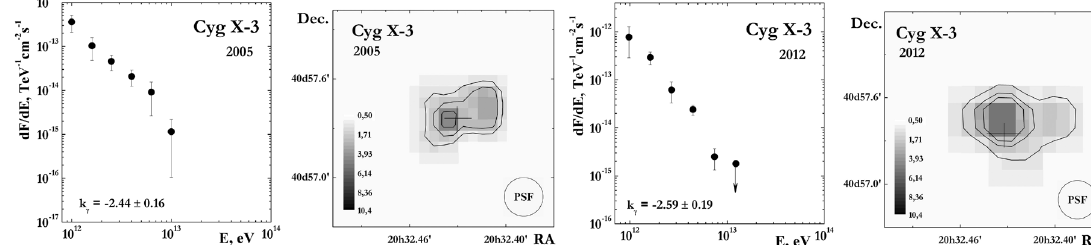
Figure 6. Di ff erential spectra of the γ -ray emission from Cyg X-3 during the flux increases and decrease in 2009. Images of Cyg X-3 at energies > 0 . 8 TeV during its flux increase in May 2009, increase in September 2009 and flux decrease in October-November 2009.